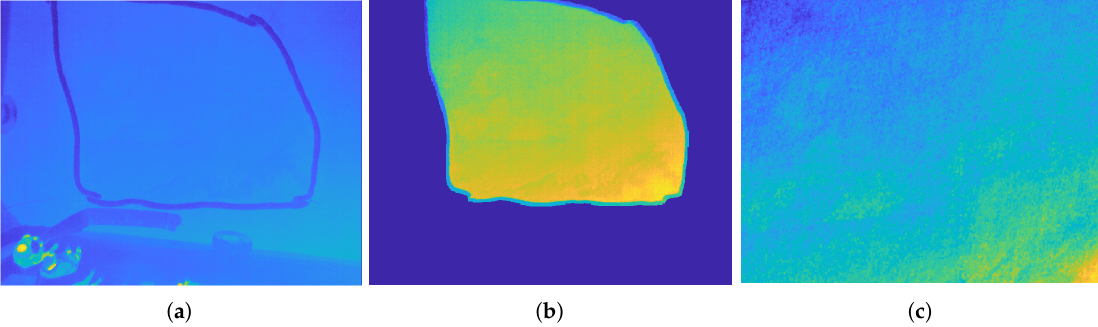
Figure 8. IR pipeline ( a ) Original thermal infrared image. ( b ) IR image with center extracted ( c ) IR image stretched to match size of the RGB